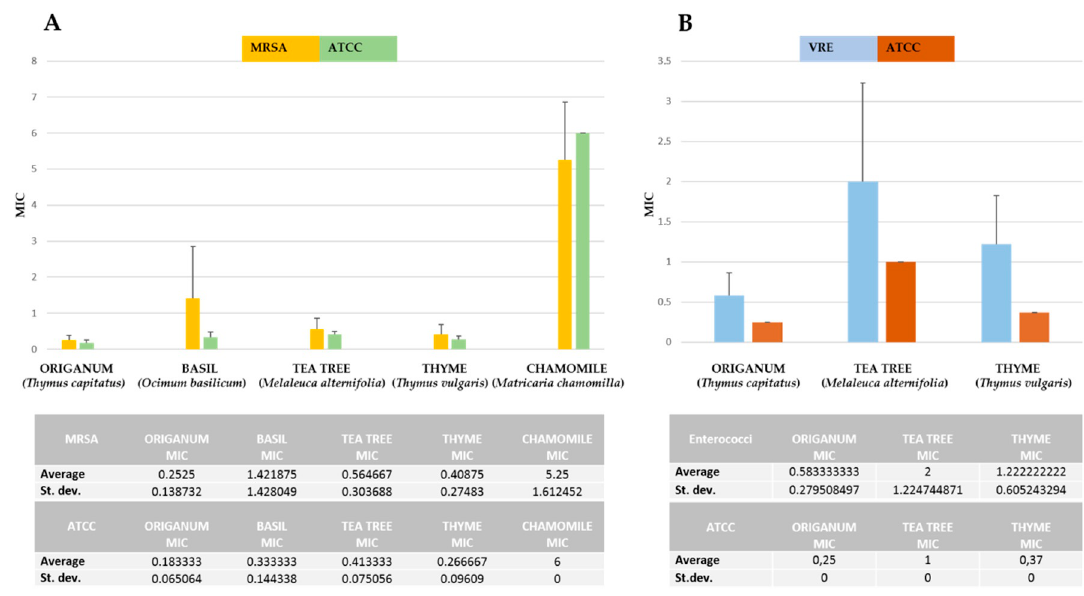
Figure 1. Comparison of MIC values of selected essential oils against wild and ATCC staphylococci ( A ), wild and ATCC enterococci ( B ). Table 3. Range of Minimal Inhibitory Concentration (MIC) and the Minimal Bactericidal Concentration (MBC) values % ( v/v ) of selected essential oils against the tested bacteria. MRSA: methicillin-resistant Staphylococcus aureus ; VRE: vancomycin-resistant enterococci. Ocimum Thymus Melaleuca Thymus Essential Oils/Bacterial basilicum capitatus alternifolia Strains